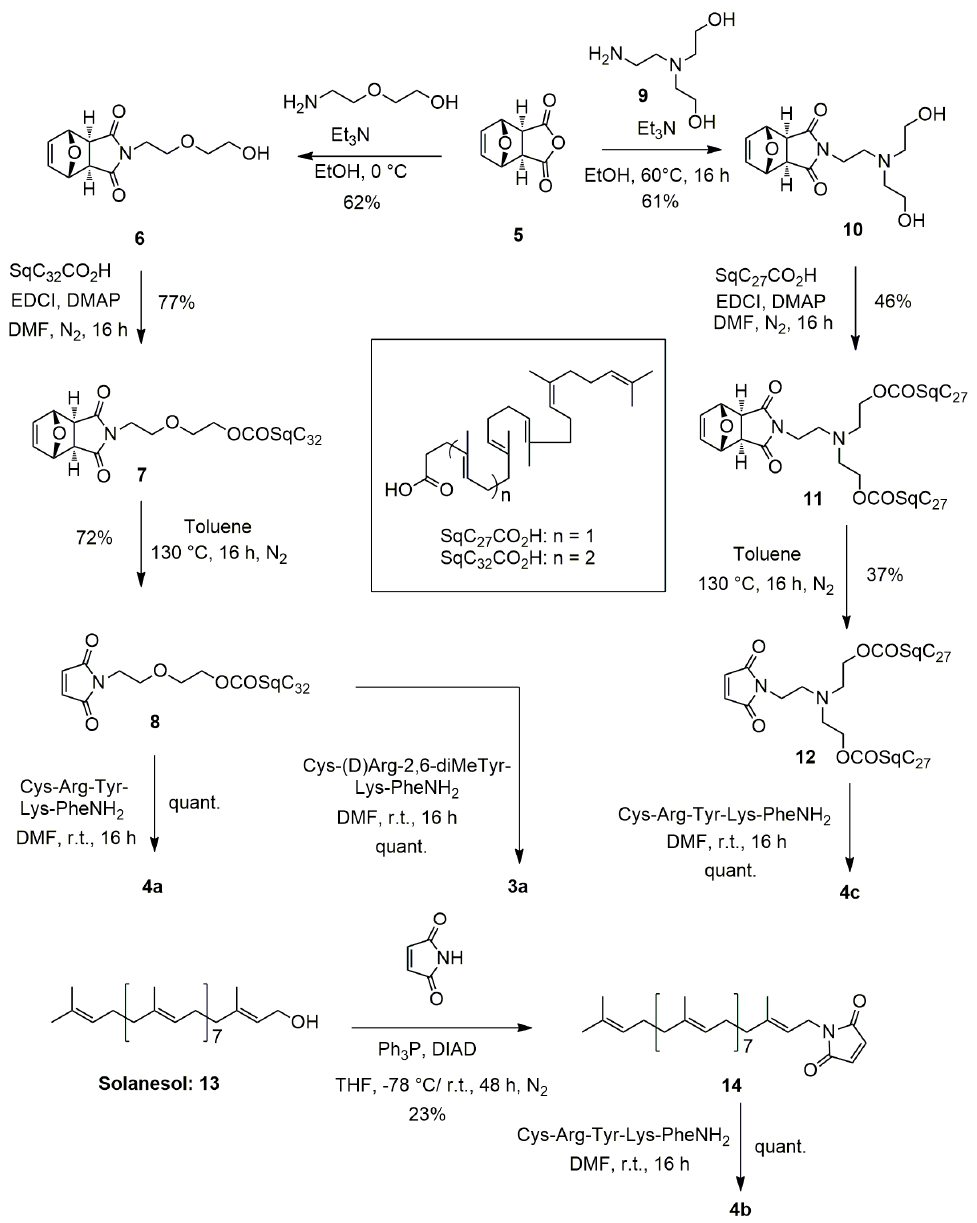
Figure 2. Synthetic scheme for obtaining bioconjugates 3a, 4a–c .